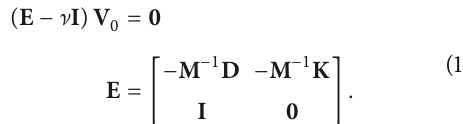
Figure 16: Shaft